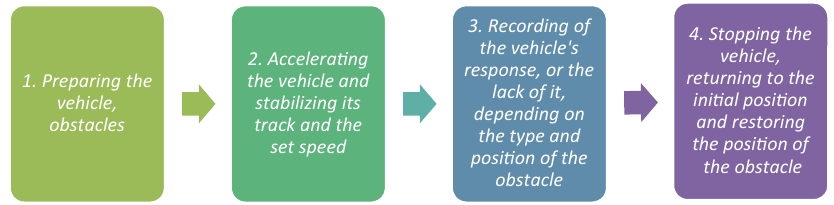
Figure 8: Research scheme. Source: “ authors ” own research.